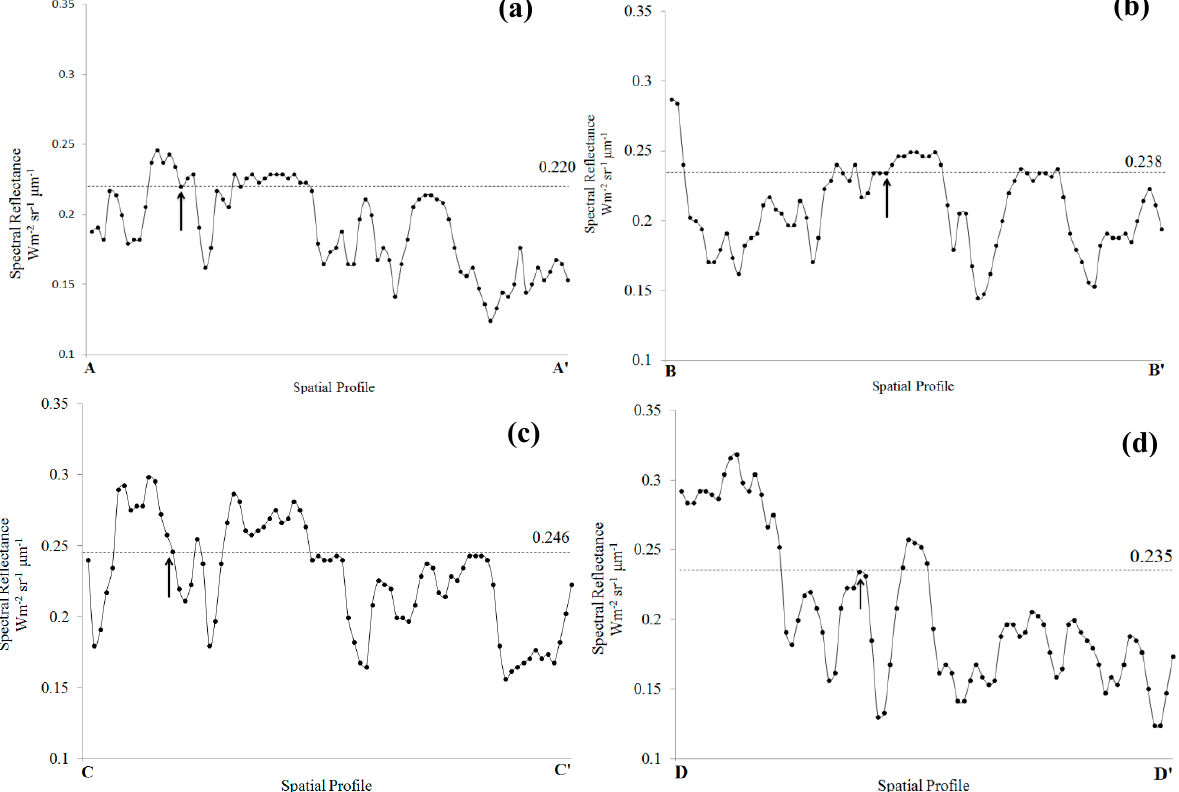
Figure 6. Maximum reflectance along the spatial profiles AA’, BB’, CC’, and DD’ that were extracted from the Landsat TM 7 image of 3 May 2003 for WCF. The maximum reflectance of approximately 0.25 (25% reflectance) along the profiles: ( a ) The maximum reflectance along the spatial profile AA’. ( b ) The maximum reflectance along the spatial profile BB’. ( c ) The maximum reflectance along the spatial profile CC’. ( d ) The maximum reflectance along the spatial profile